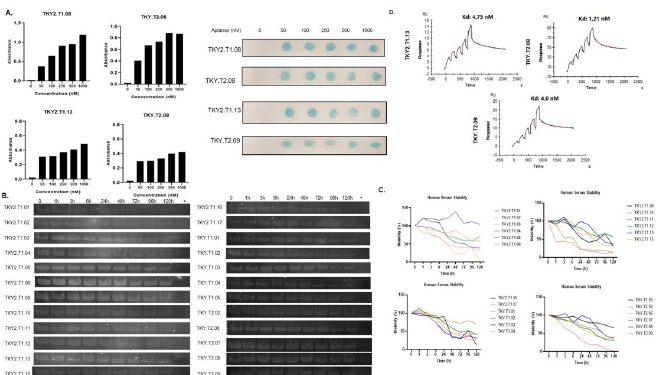
Fig 4. Determination of dissociation constant (K d ), and serum stability of putative x-aptamers. A. Stability of each putative aptamer detected by polyacrylamide gel electrophoresis of serum and aptamer mixture at 37˚C in time- dependent (0–120 h) manner. Each experiment was performed and repeated at least three times, given figures are the representative figure of one of the three assay repeat results. ns nonspecific, � p < 0.05, �� p < 0.01, ��� p < 0.001, ���� p < 0.0001 B. Binding affinity of selected x-aptamers to their specific target was demonstrated by Surface Plasmon Resonance analysis. After loading the CM-5 chip with the dose-dependent target molecule and incubation period, each aptamer was run in BiaCore T200 in triplicate for 120–12000 seconds.